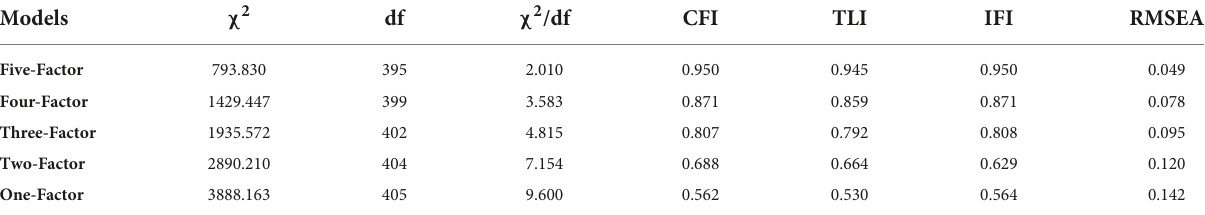
TABLE 3 Confirmatory factor analysis (CFA) results.